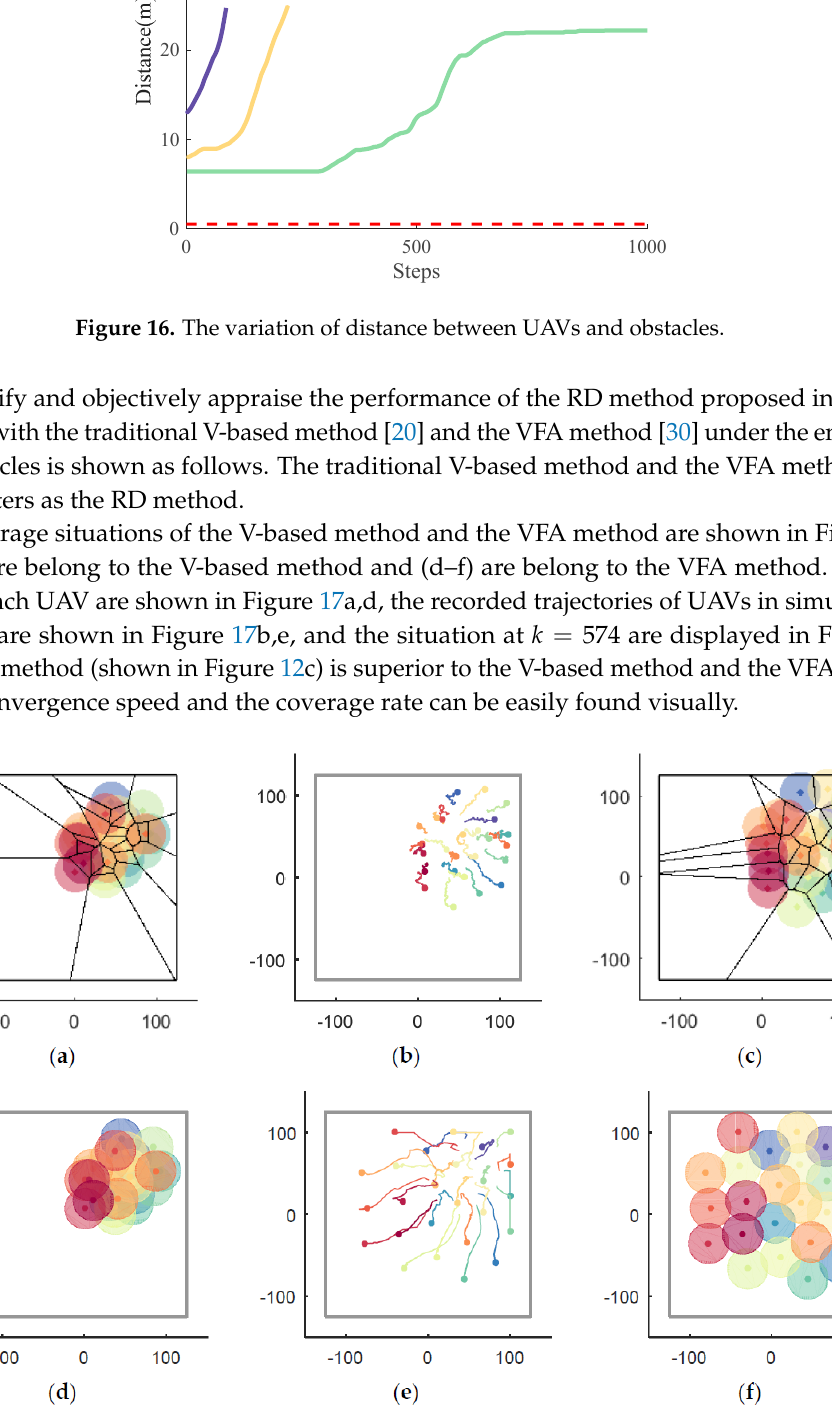
( c ) Figure 18. The recorded trajectories of UAVs generated by the simulation step  0 ~ 574 k by the RD, V ‐ based and VFA methods. ( a ) The RD method’s trajectories; ( b ) The V ‐ based method’s trajectories; ( c ) The VFA method’s trajectories. Next, the comparison of the coverage rate and deadweight loss among the RD, V ‐ based and VFA methods are exhibited in Figure 19a,b respectively, which shows that the RD method has a higher coverage rate and less deadweight loss than the other two methods at the same time. The advantage of RD in coverage rate and deadweight loss also owes to its consideration of the UAVs’ reciprocity.